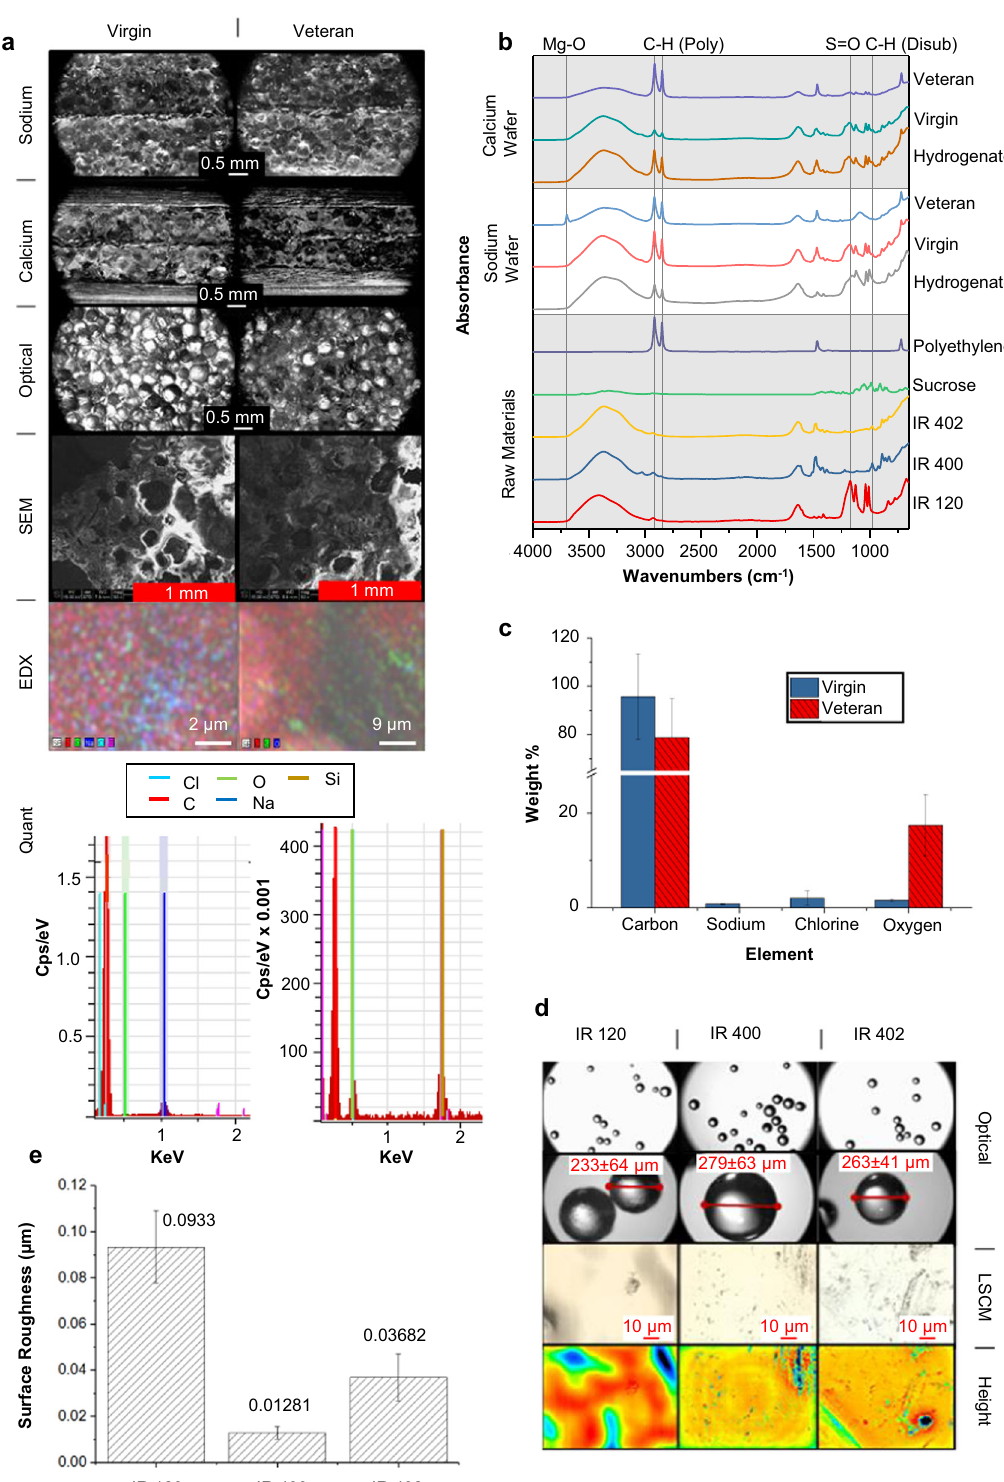
Fig. 3 Advanced material chemical and image analysis for AWEDI wafers. a Optical, scanning electron microscopy (SEM), energy dispersive X-ray analyzer (EDX), and quant graph images for a sodium selective vs. calcium selective wafer, b Fourier-transform infrared spectroscopy (FTIR) analysis of AWEDI wafers before (virgin) and after (veteran) an experiment, c chemical composition (mean ± standard deviation) of the AWEDI wafers before (virgin) and after (veteran) an experiments based on the EDX images, d optical and 3-D laser scanning confocal microscope (LSCM) images of the resin beads that make up the AWEDI wafers with their respected height map, and e surface roughness of the beads (mean ± standard